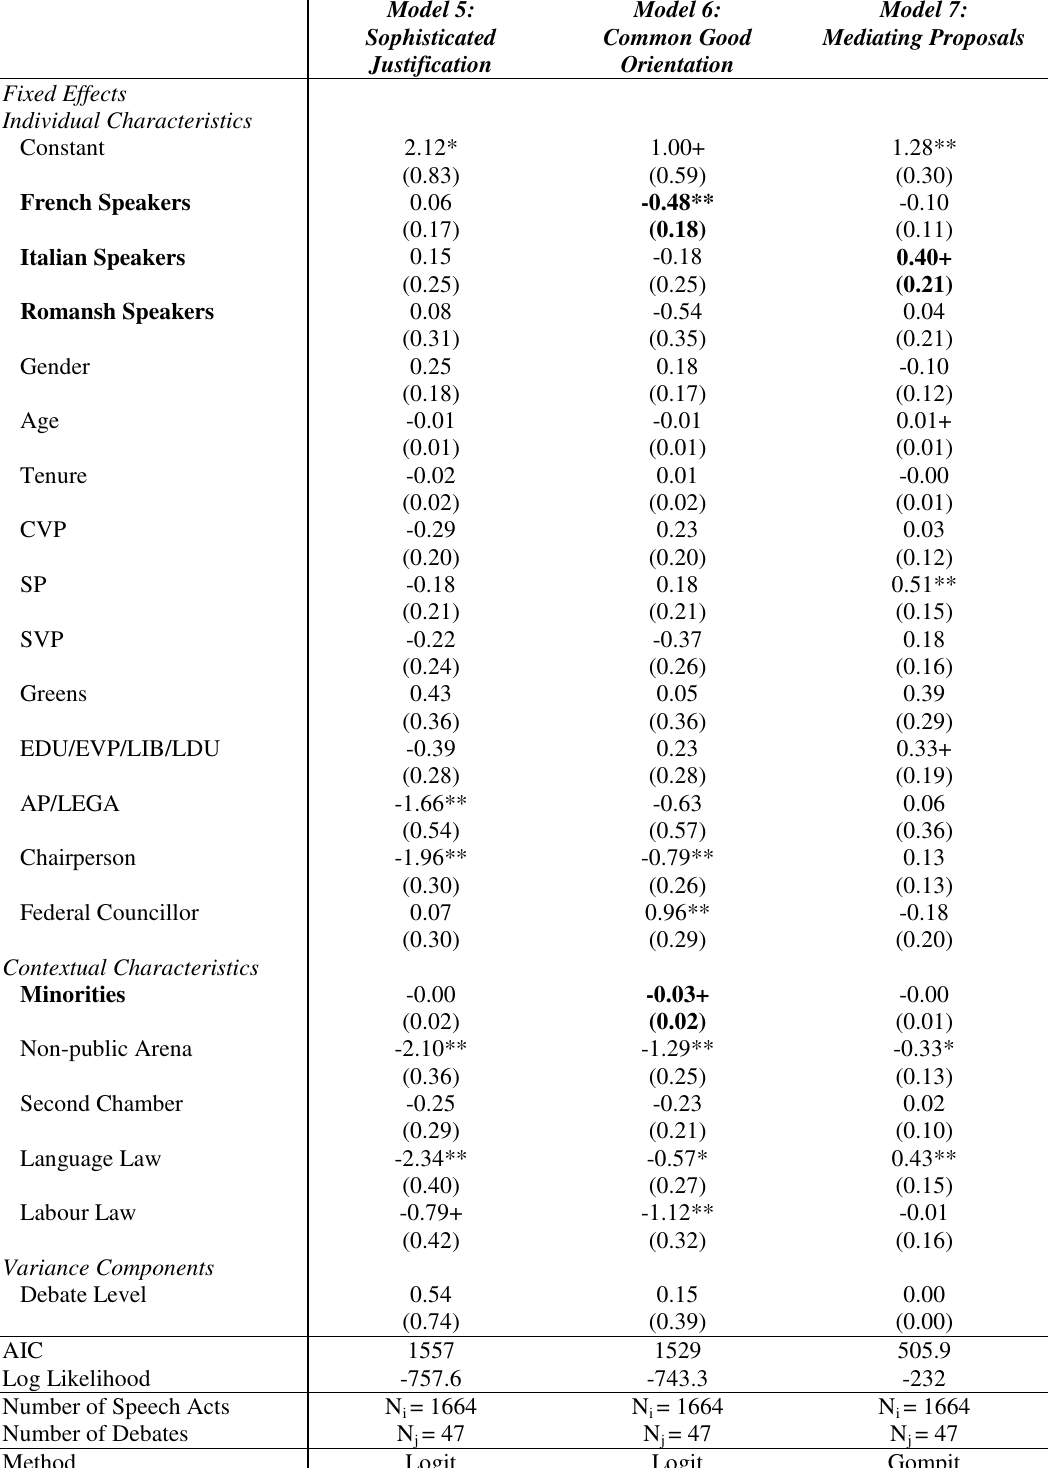
Table 4: Antecedents of Justification and Constructive Politics Model 5: